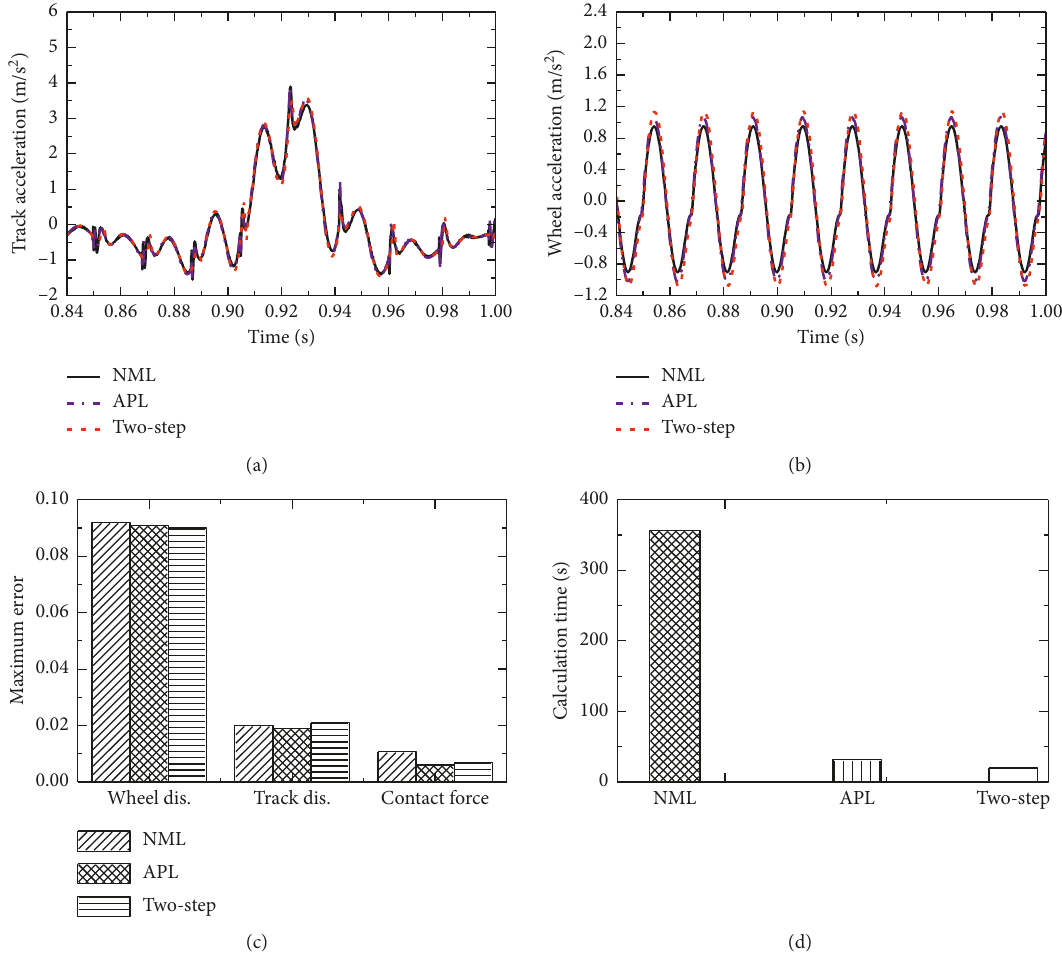
Figure 6: Responses of the vehicle-track system without irregularity: (a) acceleration of the track; (b) acceleration of the wheel; (c) the maximum error of the displacement of the wheel and the displacement at the midpoint of the track and wheel-rail force; (d) the calculation time using the NML, APL, and two-step